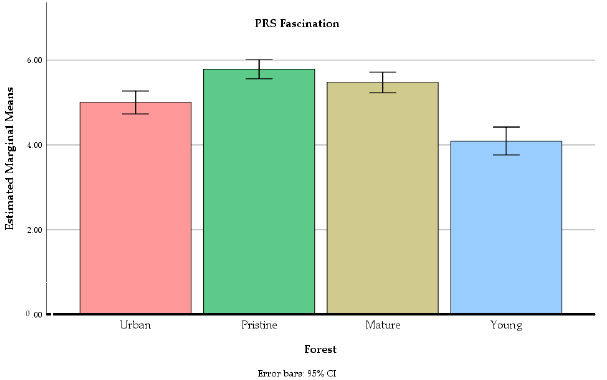
Figure 6. The mean values of PRS fascination in four different forests at the end of the experiment. Error bars represent 95% confidence intervals.